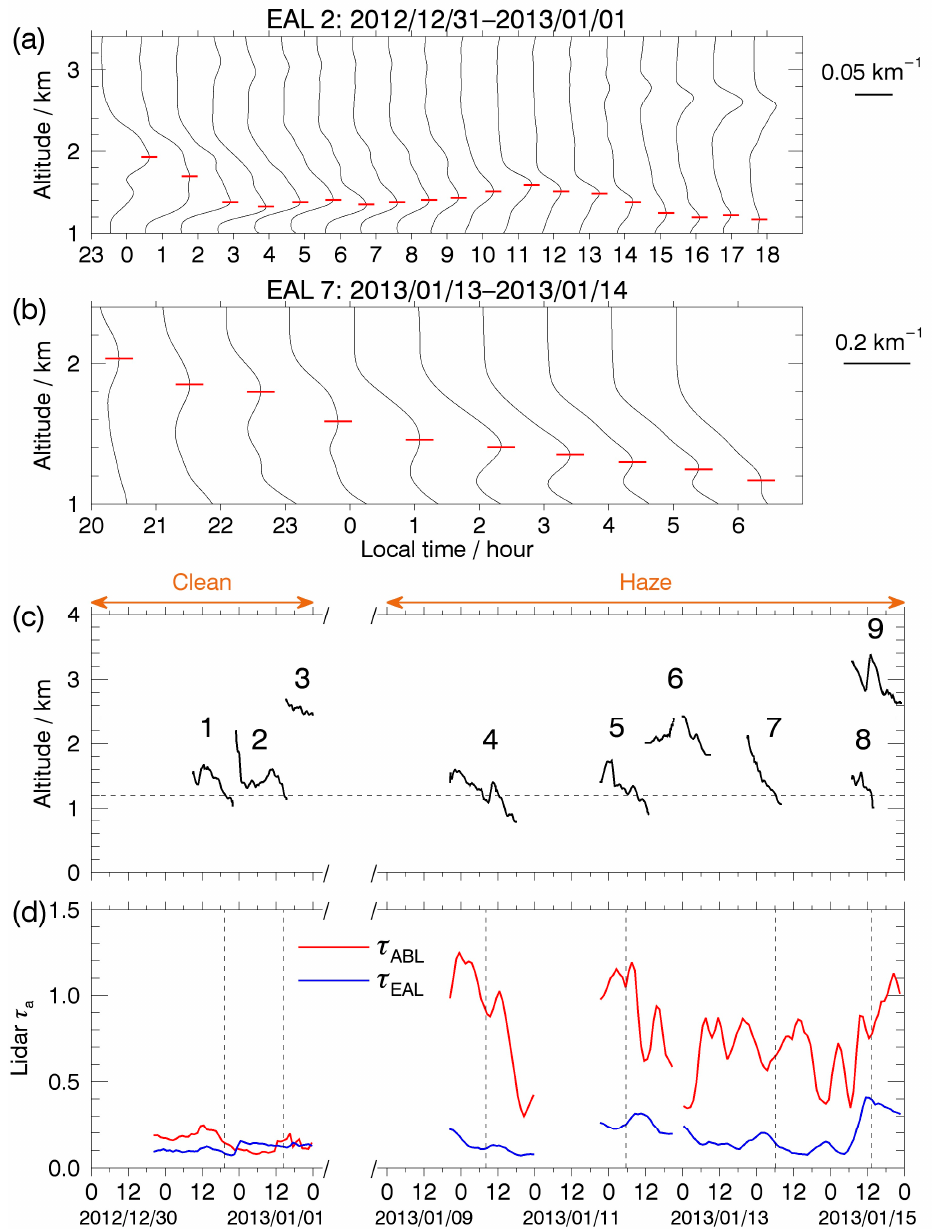
Figure 11. Time–height evolution of the elevated aerosol layers (EALs). The sequence of hourly average α a profiles from ( a ) 2300 LT on 31 December 2012 to 1800 LT on 1 January 2013 and ( b ) 2000 LT on 13 January 2013 to 0600 LT on 14 January 2013. The red short horizontal lines in panels ( a , b ) denote the EAL altitudes. Both EALs exhibited subsidence and were injected into the ABL. The time variations of ( c ) the layer altitudes for each EAL and ( d ) τ ABL and τ EAL are summarized. The horizontal dash line in panel ( c ) indicates the altitude of 1.2 km. The vertical dashed lines in panel ( d ) indicate the time when any of the EALs descended to <1.2 km.